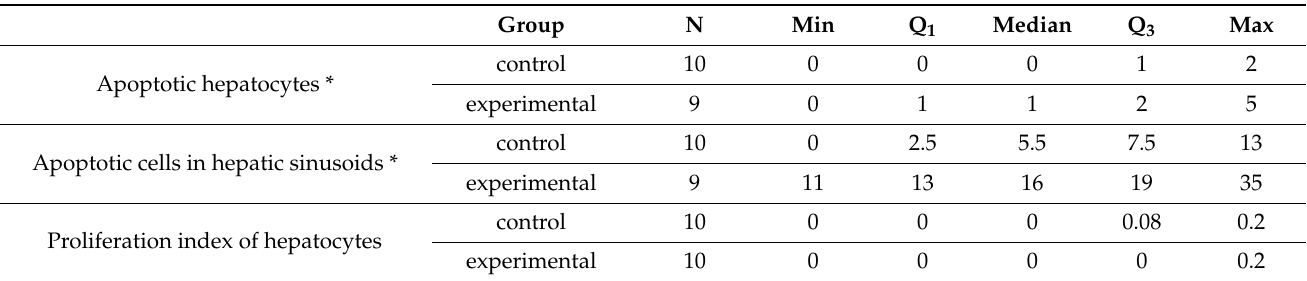
Figure 2. Representative microphotographs of apoptosis in the liver of gilts: ( A ) gilt from the control group with a single apoptotic cell in a hepatic sinusoid (arrow), ( B ) gilt from the experimental group with increased numbers of apoptotic cells in hepatic sinusoids (arrows) and an apoptotic hepatocyte (inset). TUNEL, counterstained with Mayer’s hematoxylin, bar = 50 µm. Table 3. The cumulative number of apoptotic cells and the proliferation index of hepatocytes in the liver of control and experimental gilts presented with basic descriptive statistics.